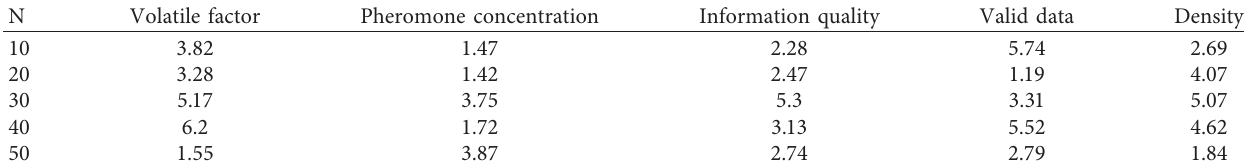
Table 4: The more frequent flow of human capital.